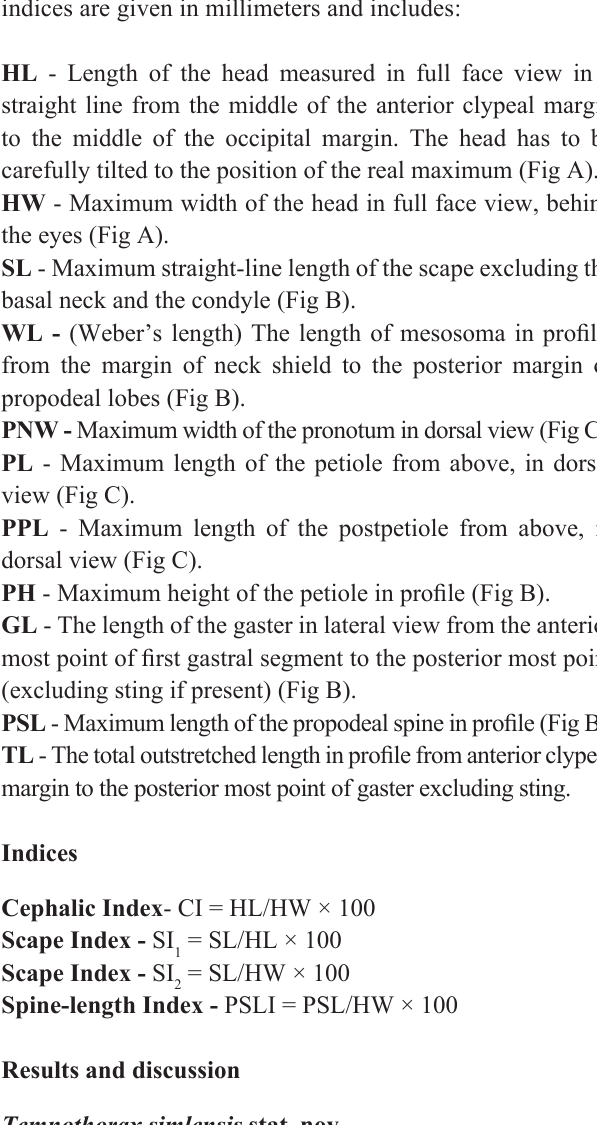
Figs A-C . Measurements of different body parts.